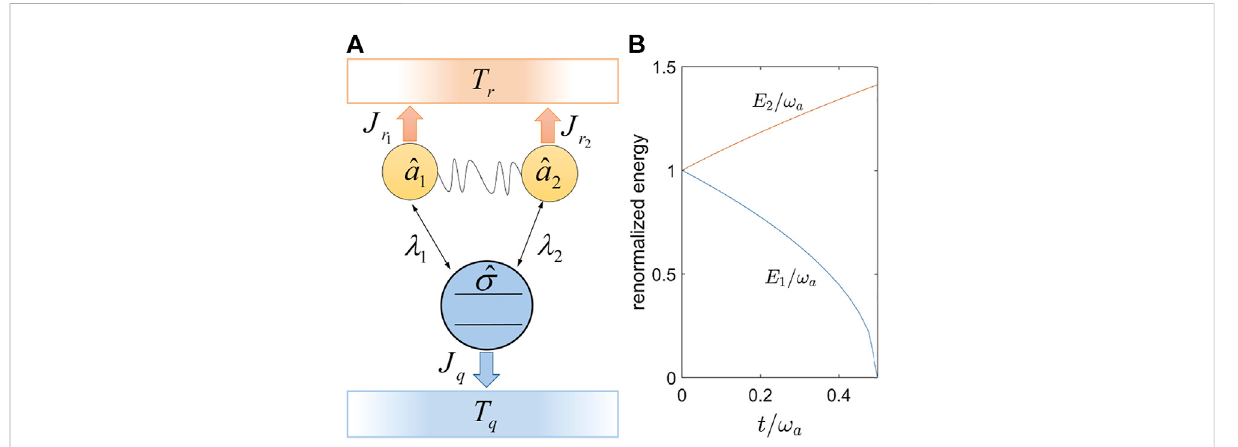
FIGURE 1 (Color online) (A) Schematic illustration of the nonequilibrium two-mode qubit-resonator model. The yellow circle marked with ^ a i denotes the i -thopticalresonator,theblackwavecurvedescribestheinteractionbetweennearest-neighbouringresonators, thebluecircleembeddedwithtwo horizontal lines and marked with ^ σ shows the two-level qubit, thedouble-arrowed line with λ i means the interaction between the i -thresonator and the qubit, and the orange (blue) rectangles is the r ( q )-th bosonic thermal reservoir, characterized as the temperature T r ( T q ). (B) eigen-energies ω a and E ω a at Eq. 4 as functions of t / ω a , with ω ω ω a E 1 / 2 / 1 = 2 =